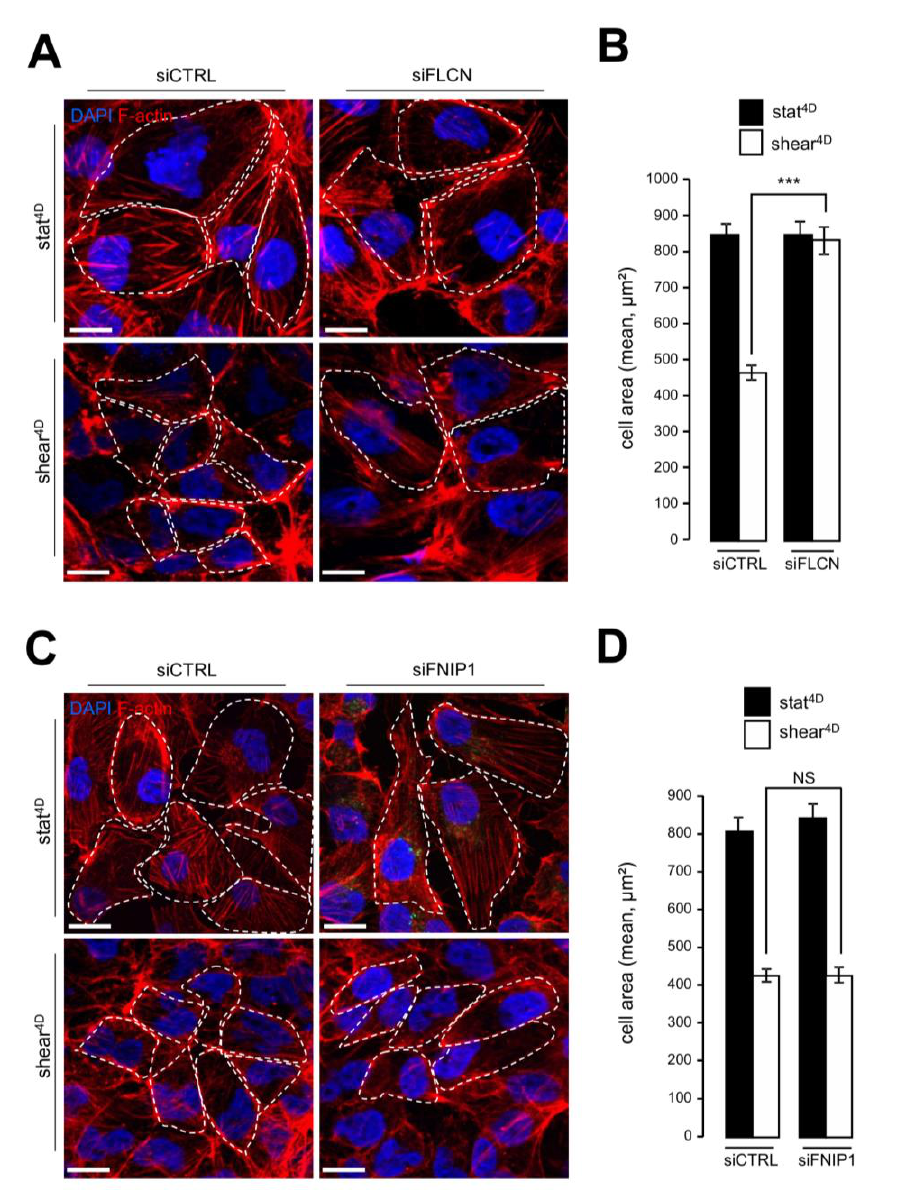
FIGURE 4: FLCN, but not